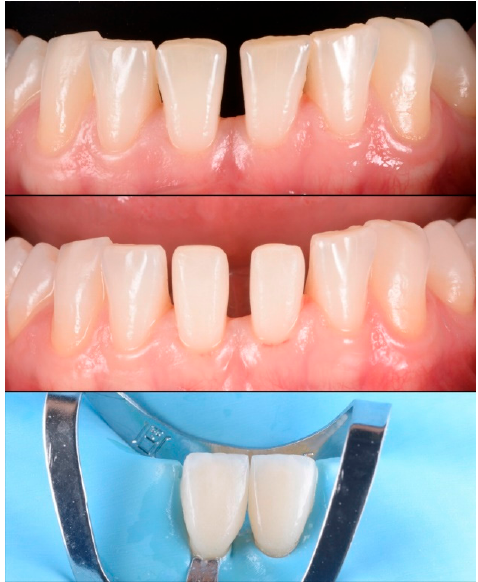
Figure 6. Minimally invasive preparation (vertical preparation) in central incisors for closing a diastema.